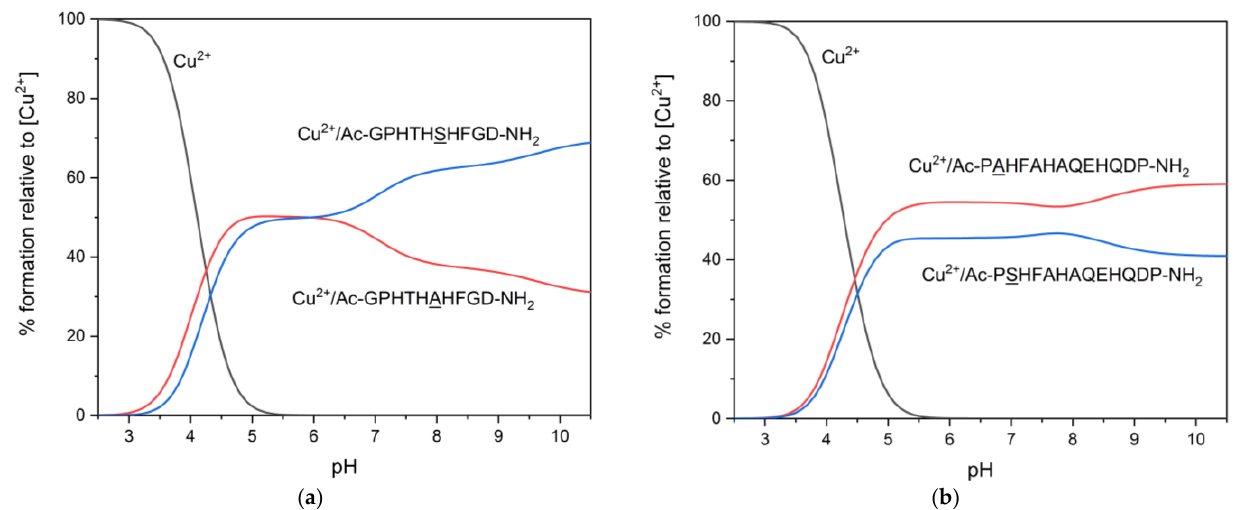
Figure 4. Competition plots for a solution containing equimolar concentrations (1 × ∙10 − 3 M) of ( a ) L1, L1_S6A and Cu 2+ ; ( b ) L2, L2_S2A and Cu 2+ . ( a ) L1, L1_S6A and Cu 2+ ; ( b ) L2, L2_S2A and Cu 2+